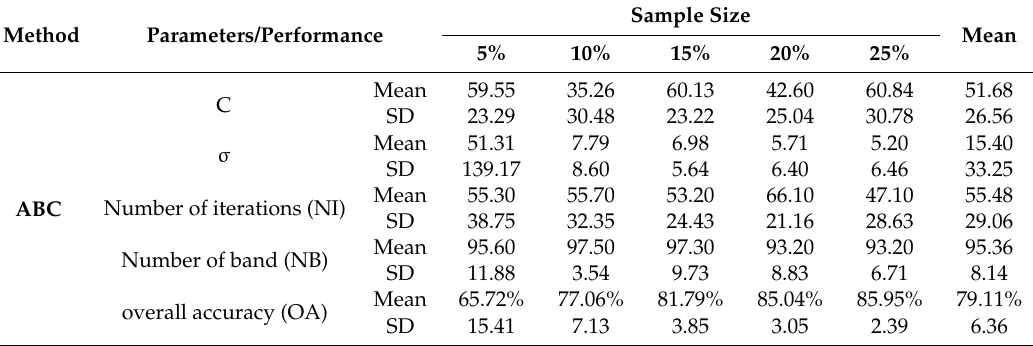
Table 2. Classification parameters and performance of the Indian Pines